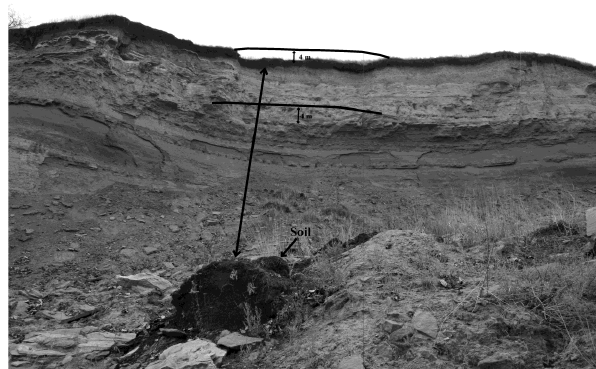
Fig. 22. The fall of the overhanging versant.